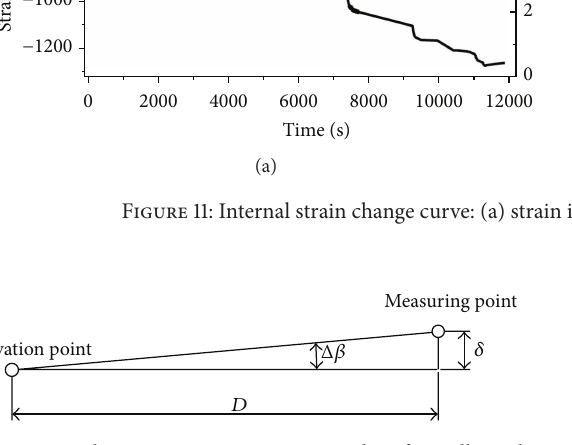
Figure 12: Displacement measuring principle of small angle method.